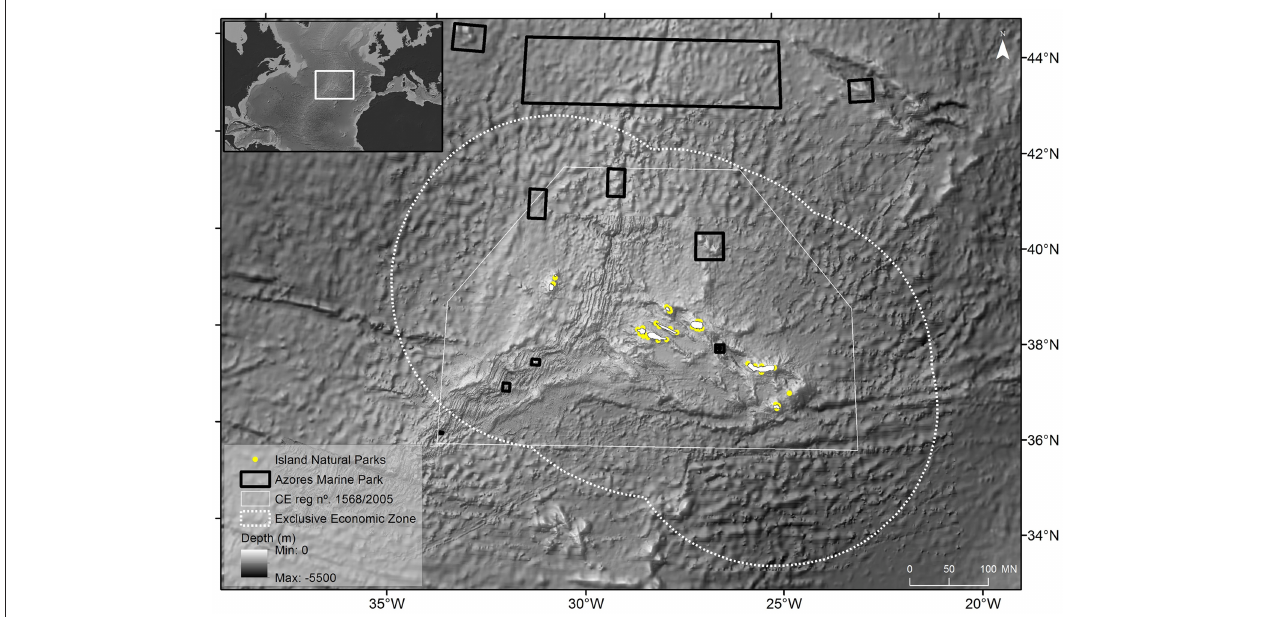
FIGURE 1 | The Archipelago of the Azores, located in the mid-North Atlantic, including the distribution of bathymetries and the current marine protected areas included in the Island Natural Parks and the Azorean Marine Park. The map also shows the limits of the Azorean Exclusive Economic Zone (EEZ) and the no-trawl area imposed by EU regulations (CE reg. 1568/2005). Graphics: R. Medeiros ©